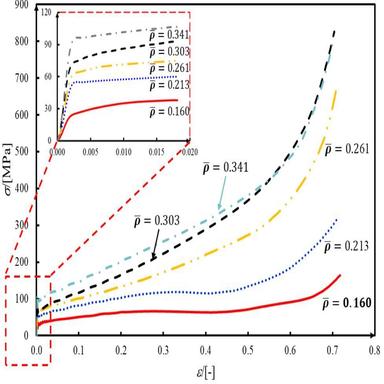
Energy absorption efficiency vs. strain curves of CLL materials with various relative densities.